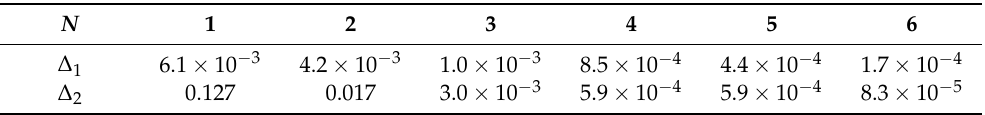
Table 5. Kolmogorov distances ∆ 1 and ∆ 2 (examples 1 and 2) between distribution functions (23) and (24) for various values of parameter N